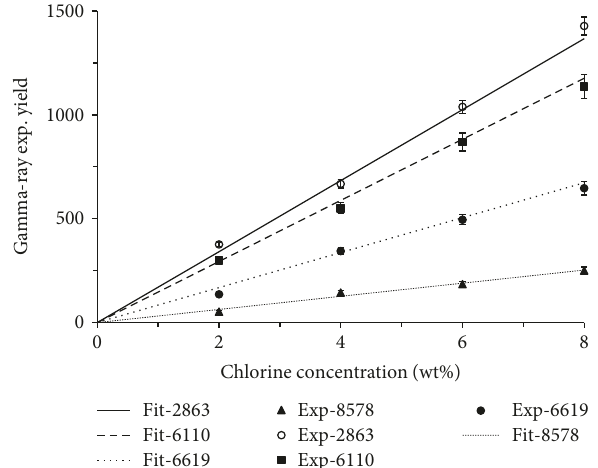
Figure 5: Integrated yield of 2863, 6110, 6619, and 8578 keV prompt gamma-ray spectra of the CeBr detector from chlorine- 3 contaminated water samples plotted as a function of chlorine concentration. The lines show normalized-calculated yields of the gamma rays obtained through Monte Carlo